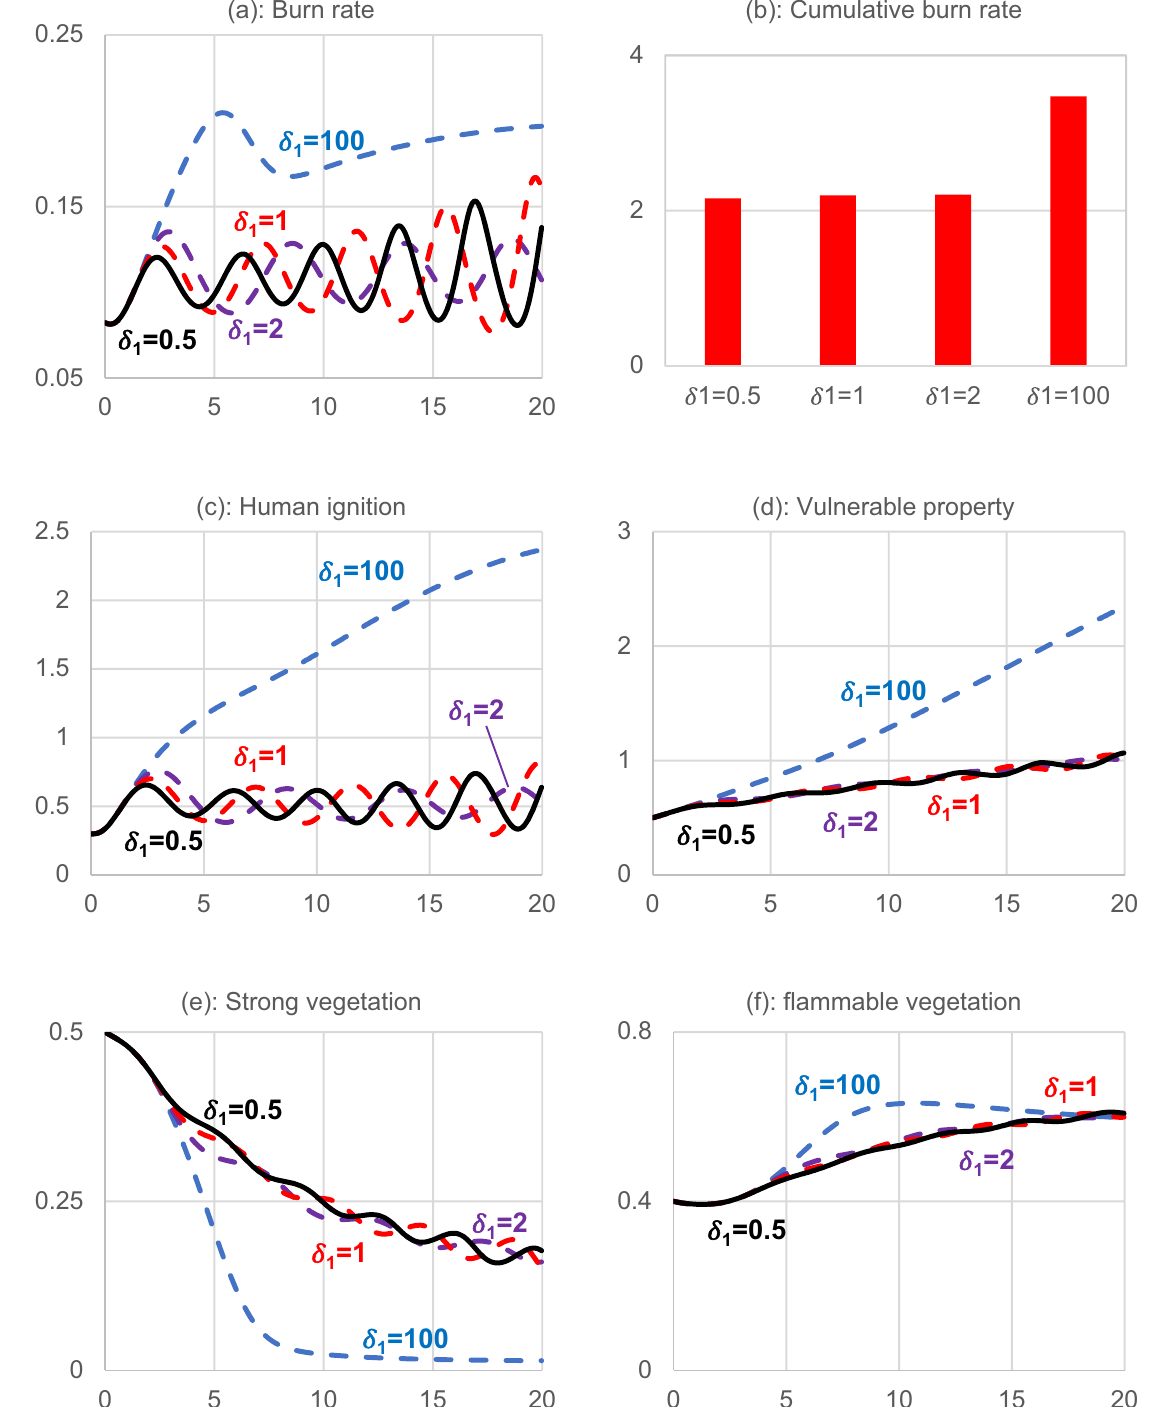
Figure 7. Coupling effect analysis for 20 years. Human ignition unit is Ignition/year, and vulnerable property unit is a million hectares. Strong vegetation and flammable vegetation are provided as the ratio that each occupied the forest